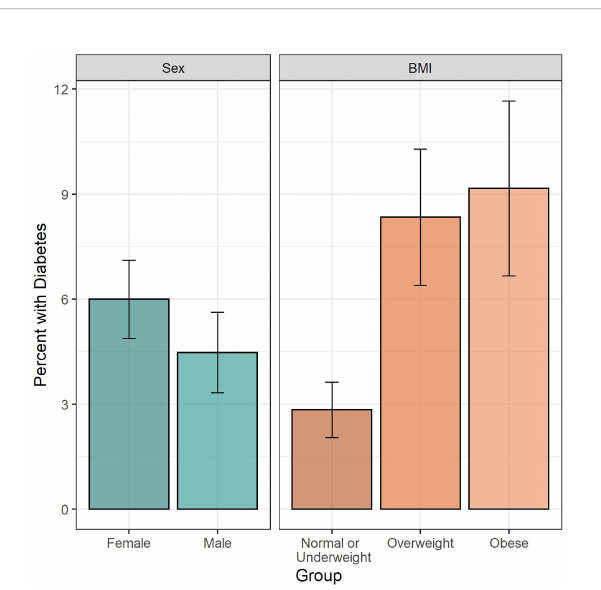
FIGURE 1 | Diabetes prevalence overall and by age. Legend: Bar height indicates estimated diabetes prevalence, with 95% CI indicated by whiskers. Left panel shows total diabetes prevalence, right panel shows diabetes prevalence disaggregated by age categories.